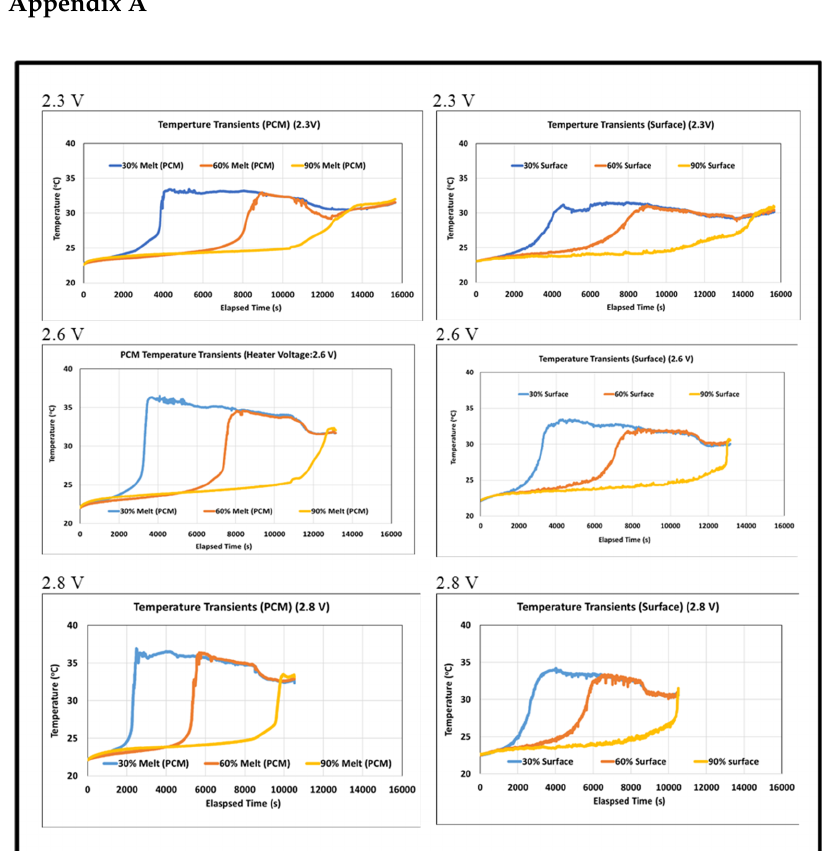
Figure A1. Plots of transient PCM-temperature data and transient surface-temperature data for different heater input voltage (and power input) conditions recorded in the experiments.